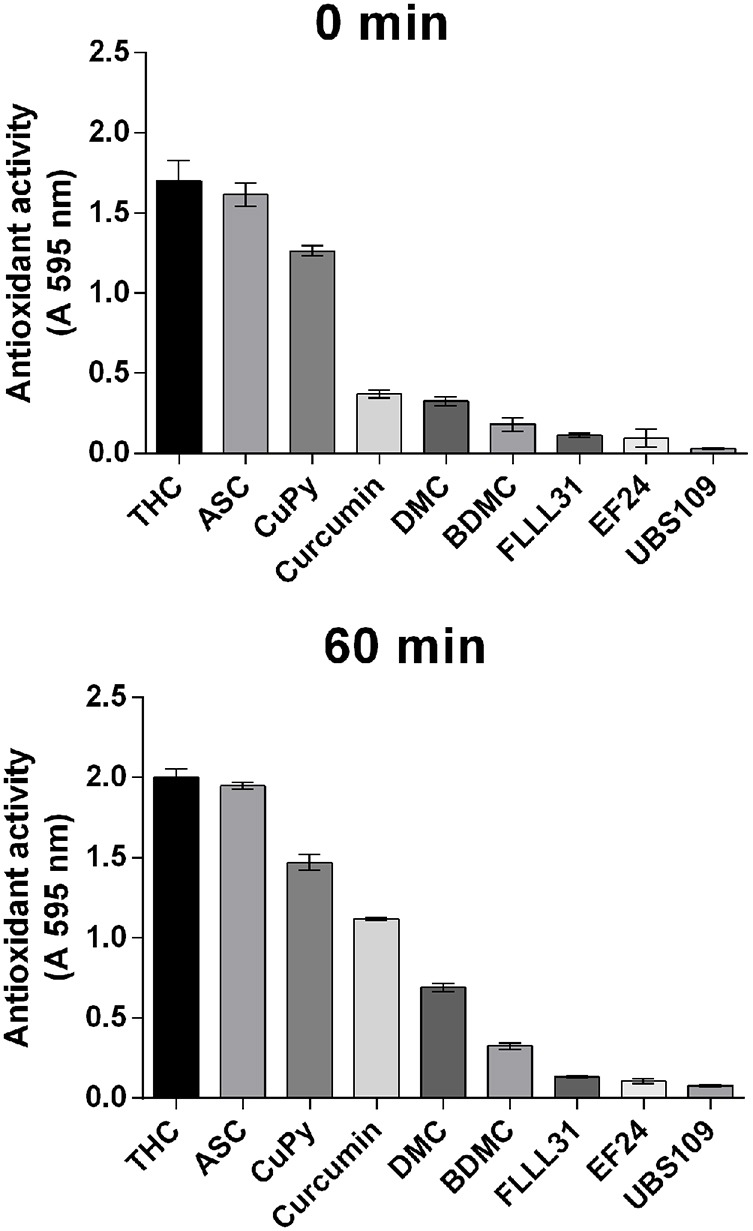
Antioxidant activity of curcumin and related structures. Reducing activity was monitored using the FRAP assay. Initial rapid (0 min) and sustained (60 min) activity was measured, using ascorbic acid as an antioxidant standard. Data are presented as mean±s.e.m. of triplicate experiments.